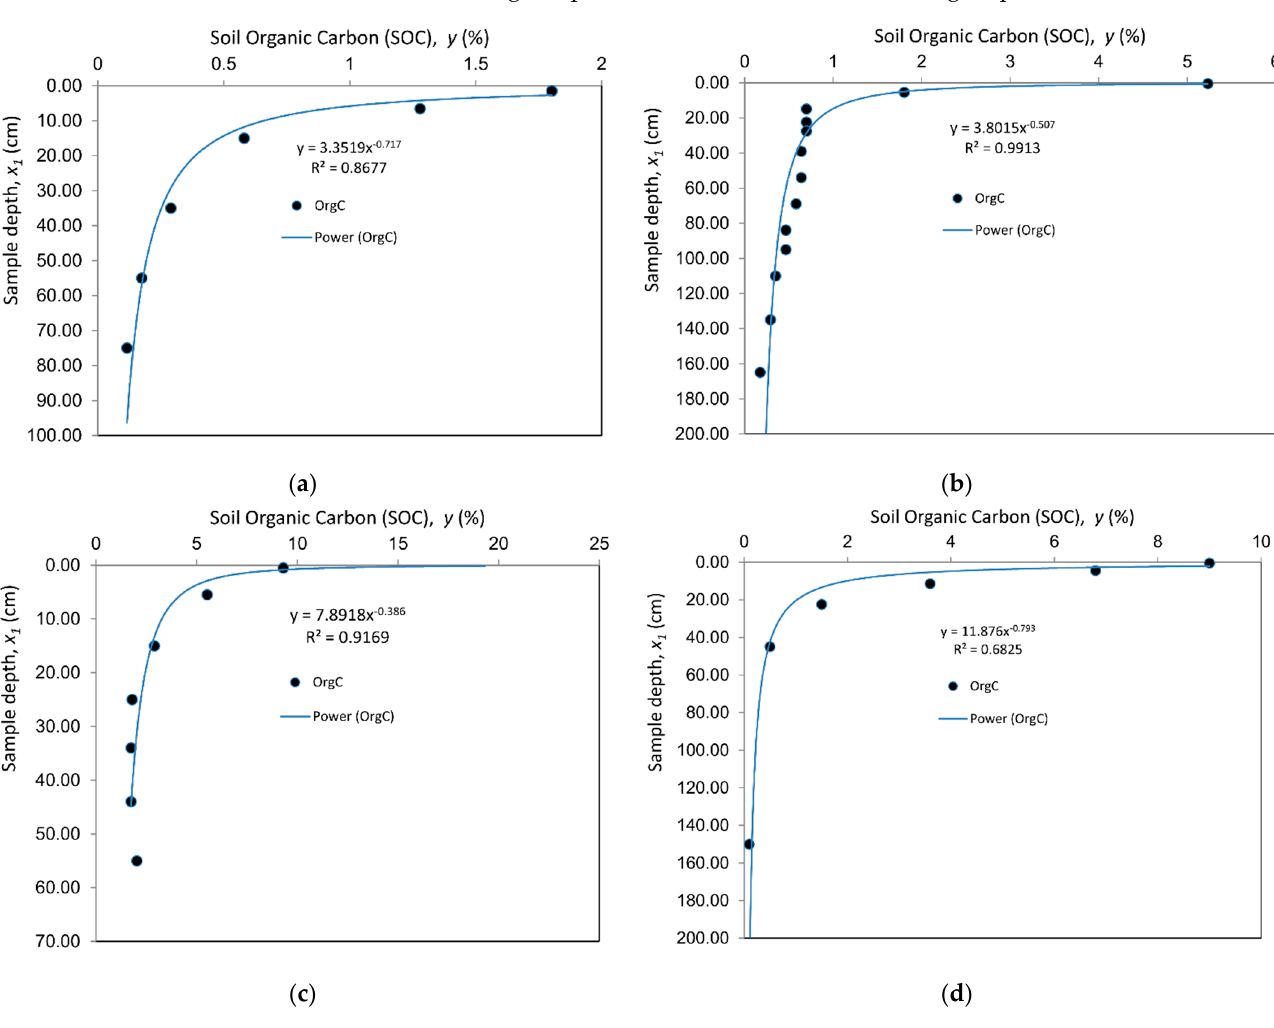
Figure 3. SOC models: ( a ) Vertosol profile (site A978) from the Wimmera; ( b ) Sodosol profile (site 485) from Boorook (south-western Victoria); ( c ) Dermosol profile (site 488) at Girringurrup (south-western Victoria); ( d ) Rudosol profile (site OTR426) from Wangerrip (Otway Ranges). Note that SOC models are presented with axes (x and y) reversed for display purposes.